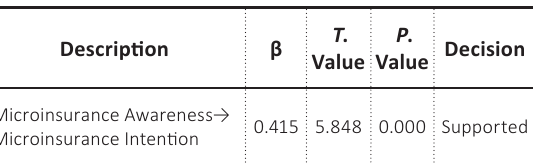
Table 7. Hypothesis testing